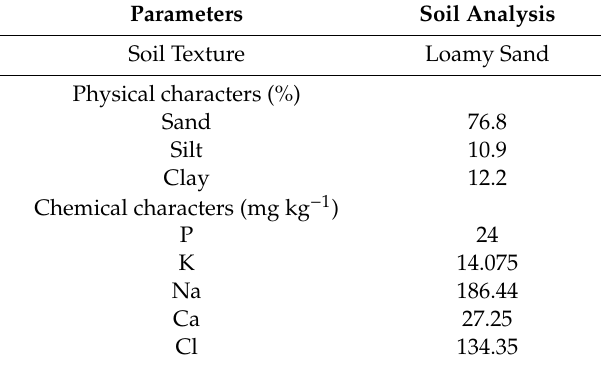
Table 1. Physical and chemical characteristics of the soil used in the greenhouse